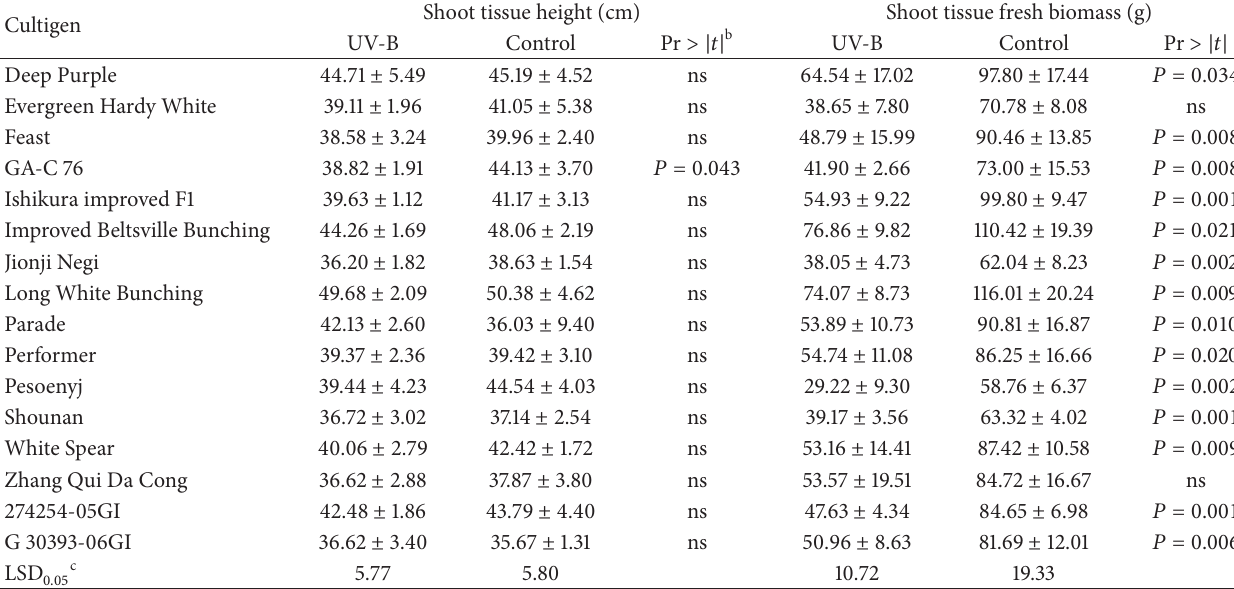
a Composition of 𝑛 = 6 plant samples from 4 replications ± standard deviation. b Significance based on paired Student’s t -test among treatments; ns: not significant. c LSD for differences between cultivar means 𝛼 = 0.05 .